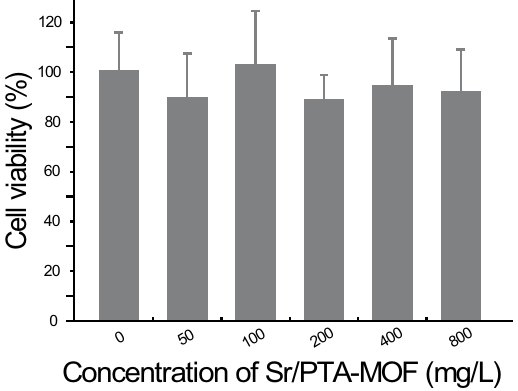
Figure 6. MTT cytotoxicity assay of Sr/PTA-MOF towards chondrocyte at various